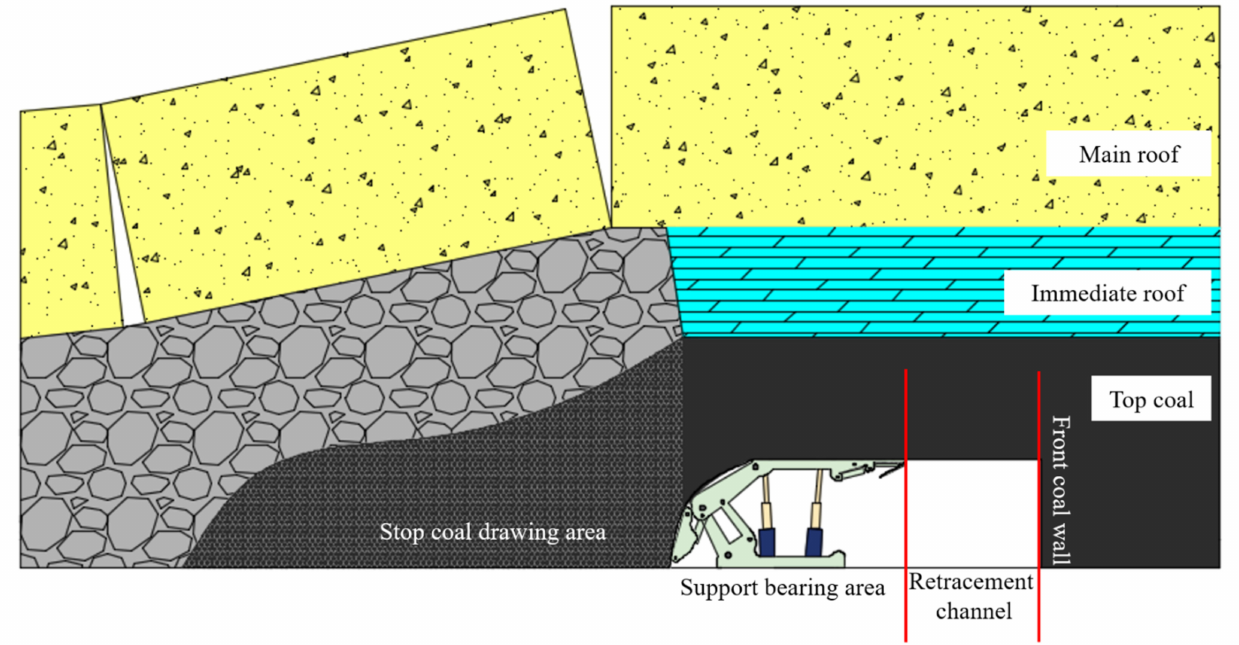
Figure 22. Illustration of the stopping space zoning in fully mechanized top coal caving min- ing